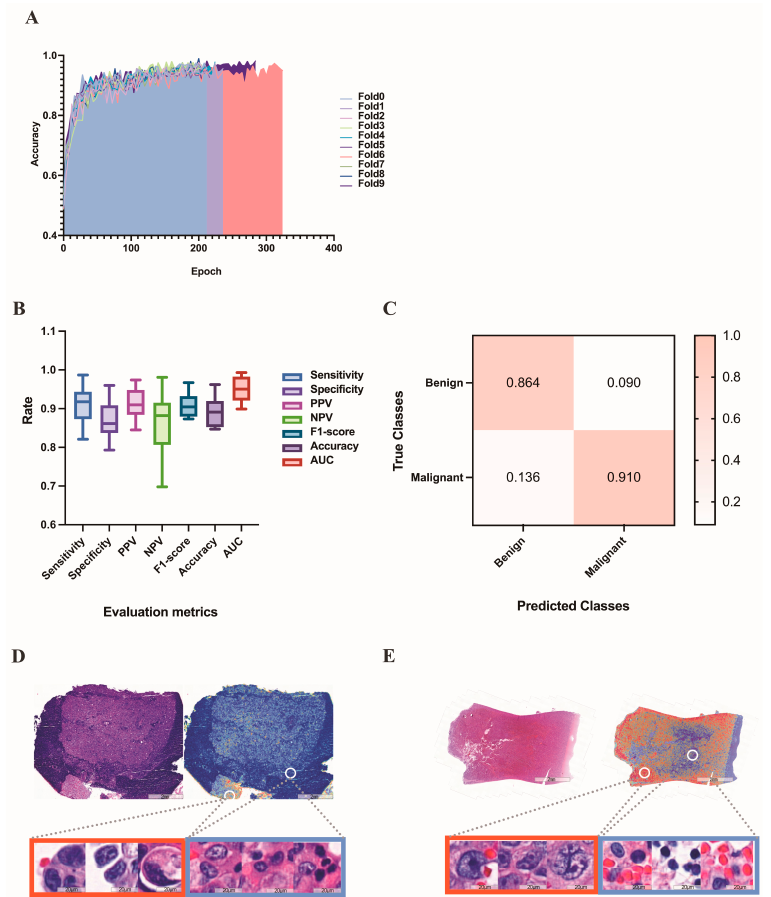
Figure 6. Results of the deep learning model for differentiating benign and malignant pleural effusion. ( A ) The learning curve of the deep learning model in distinguishing between benign and malignant WSI images. ( B ) Evaluation metrics in test set of benign vs. malignant dataset. ( C ) Confusion matrix in test set of benign vs. malignant dataset. ( D ) A HE-stained image of breast invasive ductal carcinoma, corresponding heatmap and magnified pictures of different attention regions in the heatmap. The redder the color, the higher the confidence of the malignancy. ( E ) Another example of an HE-stained image of gastric adenocarcinoma, corresponding heatmap and magnified pictures of different attention regions in the heatmap. 3.3. Deep Learning Models in the Identification of the Primary Site of Metastatic Cancer Next, we evaluated the performance of our method on the more difficult task of dif- ferentiating between pleural effusions of common metastatic carcinomas. The task was trained on 224 cases of breast carcinoma (augmented by 56 cases of breast carcinoma), 238 cases of gastric adenocarcinoma (augmented by 34 cases of gastric adenocarcinoma), and 246 cases of lung adenocarcinoma. It was validated on 19 cases of breast carcinoma, 11 cases of gastric adenocarcinoma, and 82 cases of lung adenocarcinoma, and tested on 19 cases of breast carcinoma, 11 cases of gastric adenocarcinoma, and 82 cases of lung